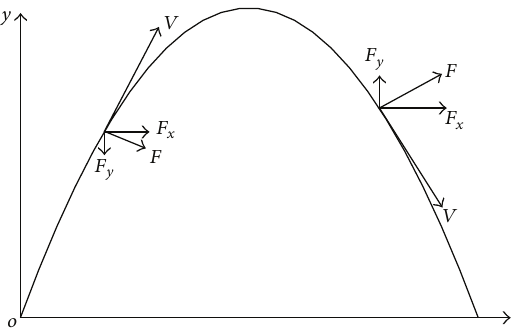
Figure 8: Schematic of aerodynamic force caused by canards deflection.